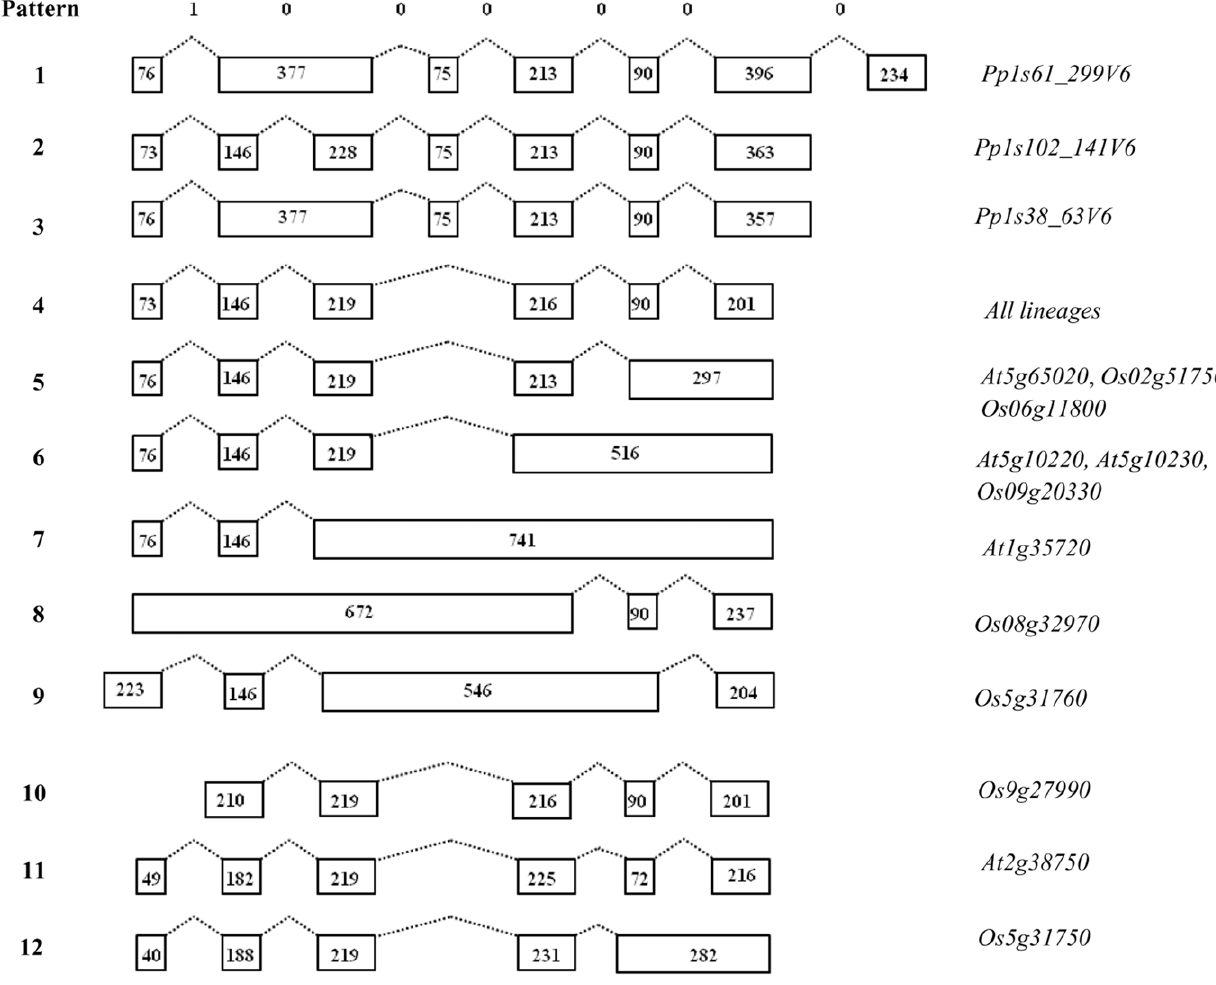
Figure 4. Exon-intron organizations of annexin genes from genomes of moss, spike moss, Arabidopsis and rice. Exons and introns are indicated as open boxes and dotted lines respectively. The intron phases are depicted as 0 and 1 at the top. Numbers at the left show intron-exon patterns and those at the right show the type of pattern observed in different genes across genomes. Numbers within the boxes represent exon sizes. The exons and introns are not drawn to